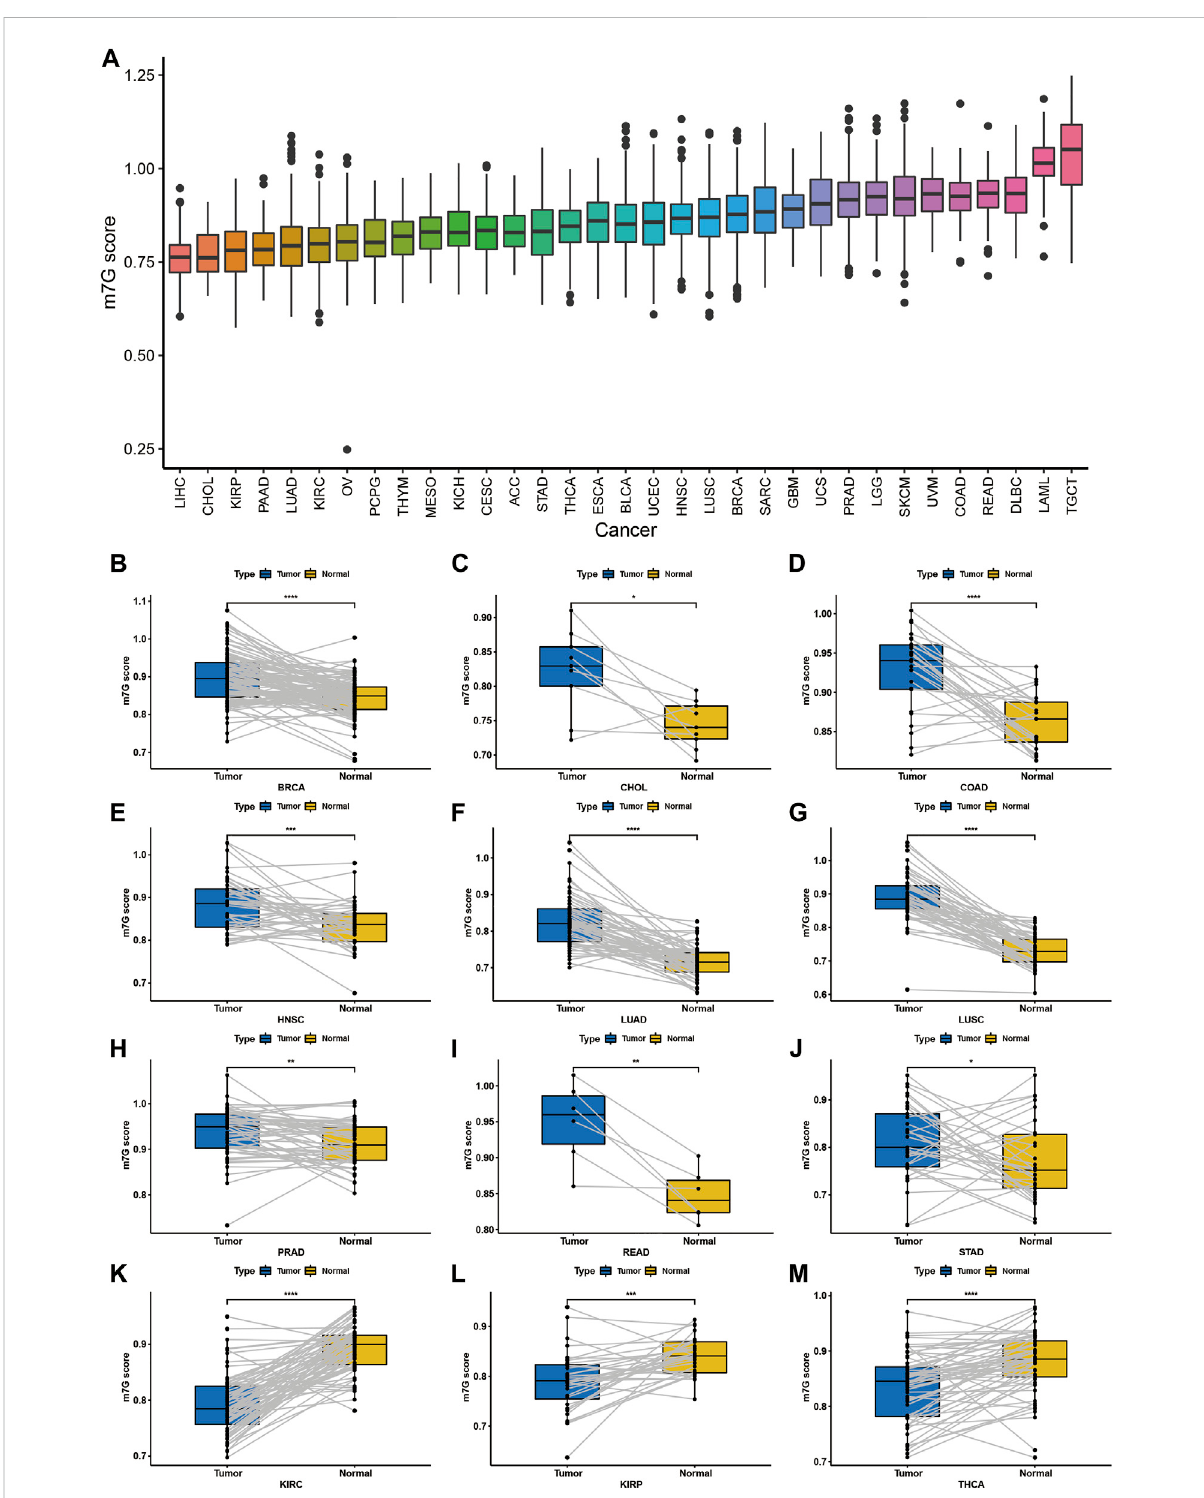
FIGURE 2 Establish modeling of the m7G modi fi cation level among cancers. (A) m7G modi fi cation levels in 33 cancers. (B – J) m7G modi fi cation levels were elevated in tumor tissues (BRCA, CHOL, COAD, HNSC, LUAD, LUSC, PRAD, READ and STAD) than the corresponding normal tissues. (K – M) m7G modi fi cation levels were decreased in tumor tissues (KIRC, KIRP and THCA) than the corresponding normal